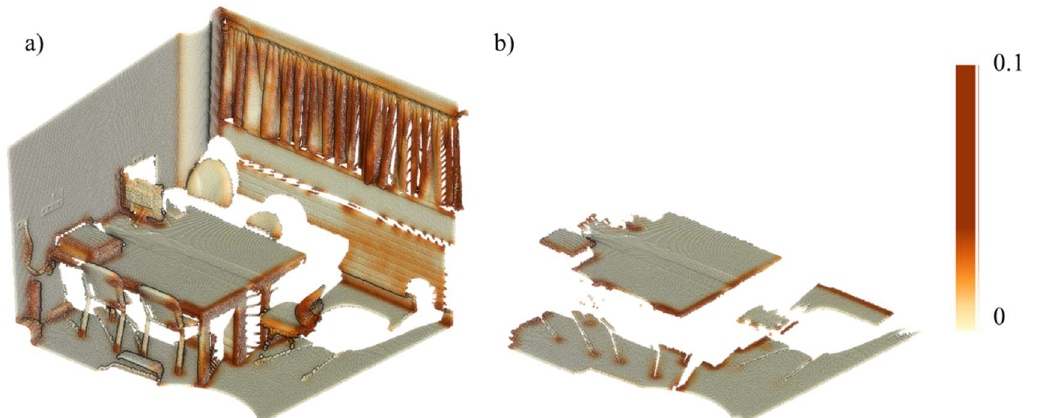
Figure 7 . Morphological opening for horizontal surface segmentation in indoor environment coloured by curvature: a) input point cloud, b) segmented point